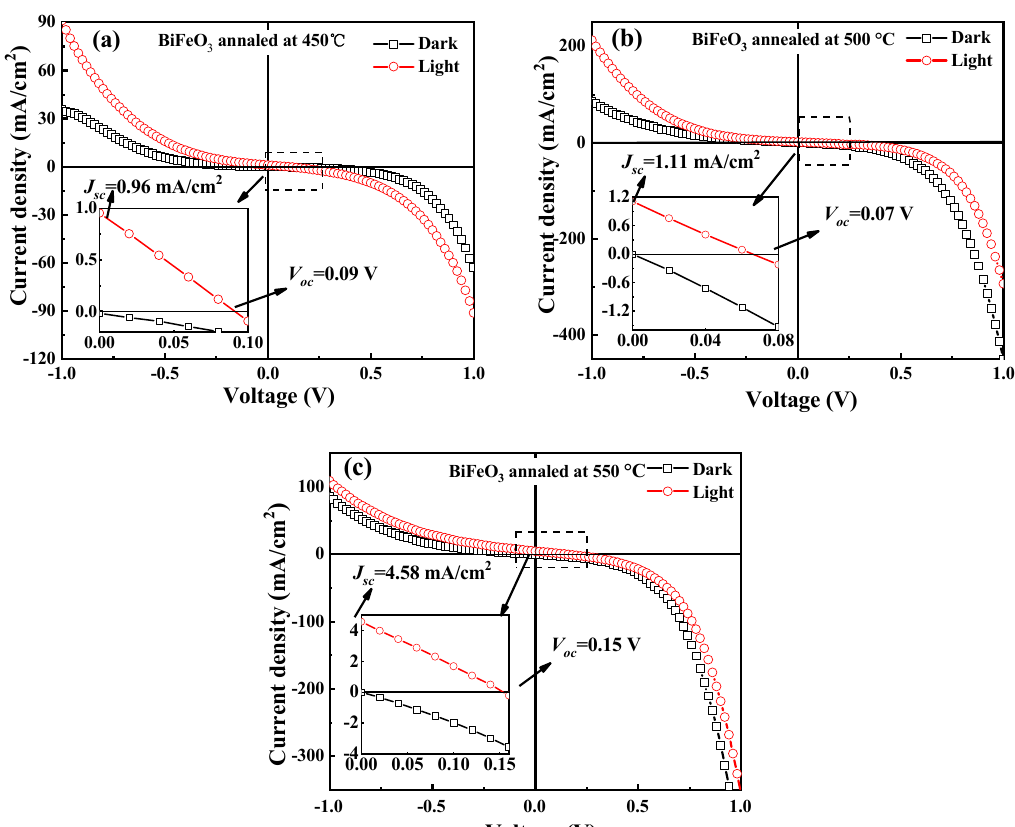
Figure 7. The J-V curves of BFO thin films annealed at various temperature under dark current, and 365 nm and 250 mW/cm 2 laser lamp irradiation at ( a ) 450 °C, ( b ) 500 °C and ( c ) 550 °C. Table 1. The grain size, Fe 3+ /Fe 2+ ratio, O in metal/O in defect ratio, band gap (E g ), short circuit photocurrent density (J sc ) and the open circuit photovoltage (V oc ) of BFO thin films annealed at different temperatures.